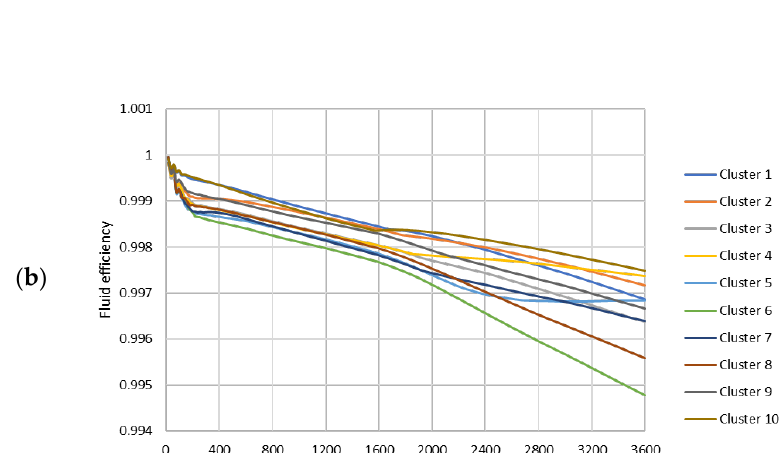
( c ) Figure A1. Fluid efficiency of each cluster during the hydraulic fracturing treatment. ( a ) Slick water case. ( b ) NG foam case. ( c ) Hybrid NG/NG foam case.